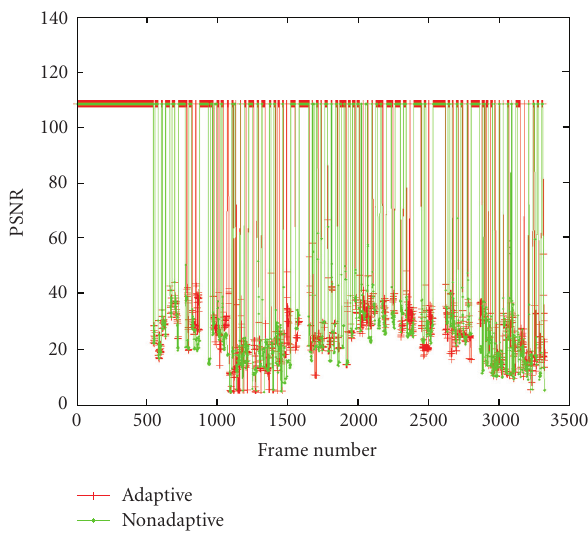
Figure 12: PSNR comparisons for “ all ” sequence at 64kbps, random delay 0.02, bu ff er size 250, packet size 256, span 16, PL rate 18.63%.